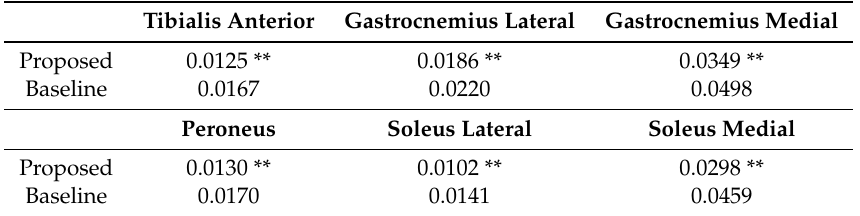
Table 3. Median root mean squared errors [mV] of the proposed and baseline method (** p < 0.01).